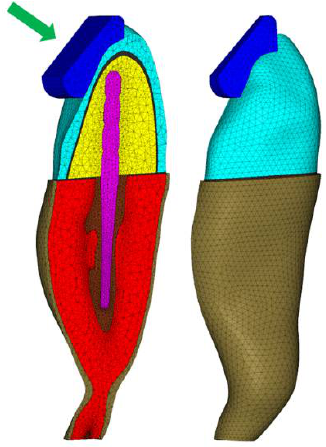
Figure 1. Finite element (FE) model according to the components in the geometric model.